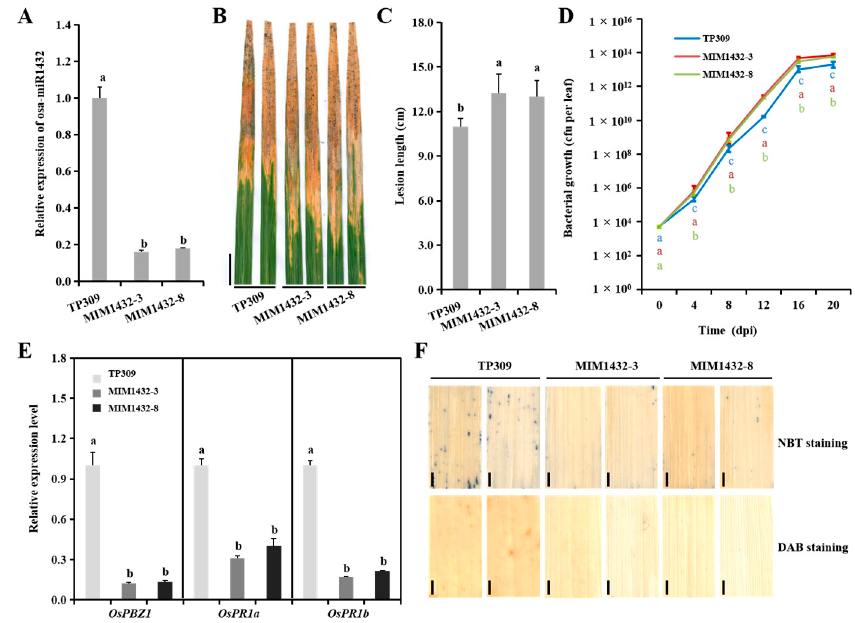
Figure 3. Restraining the expressing of osa-miR1432 results in susceptibility to Xoo attack in rice. ( A ) The expression detection of osa-miR1432 in MIM1432 lines, SnRNA U6, served as the internal reference. ( B ) Lesions on MIM1432 lines (MIM1432-3 and MIM1432-8) and TP309 at 20 dpi. Scale bar, 2 cm. ( C ) Lesion lengths on MIM1432 lines ( n = 20) at 20 dpi. ( D ) Bacterial growth as indicated by the numbers of colony-forming units (cfu) per leaf in MIM1432 lines and TP309. ( E ) The basic expression of OsPBZ1 , OsPR1a and OsPR1b in MIM1432 transgenic lines and TP309. ( F ) The histochemical detection of ROS levels using NBT and DAB staining in MIM1432 lines and TP309 at 4 dpi. Error bars indicate standard deviation ( n = 3). Scale bar, 2 mm. Different letters above the bars indicate significant differences ( p < 0.01) determined by one-way analysis of variance (ANOVA) followed by post hoc Tukey HSD analysis.